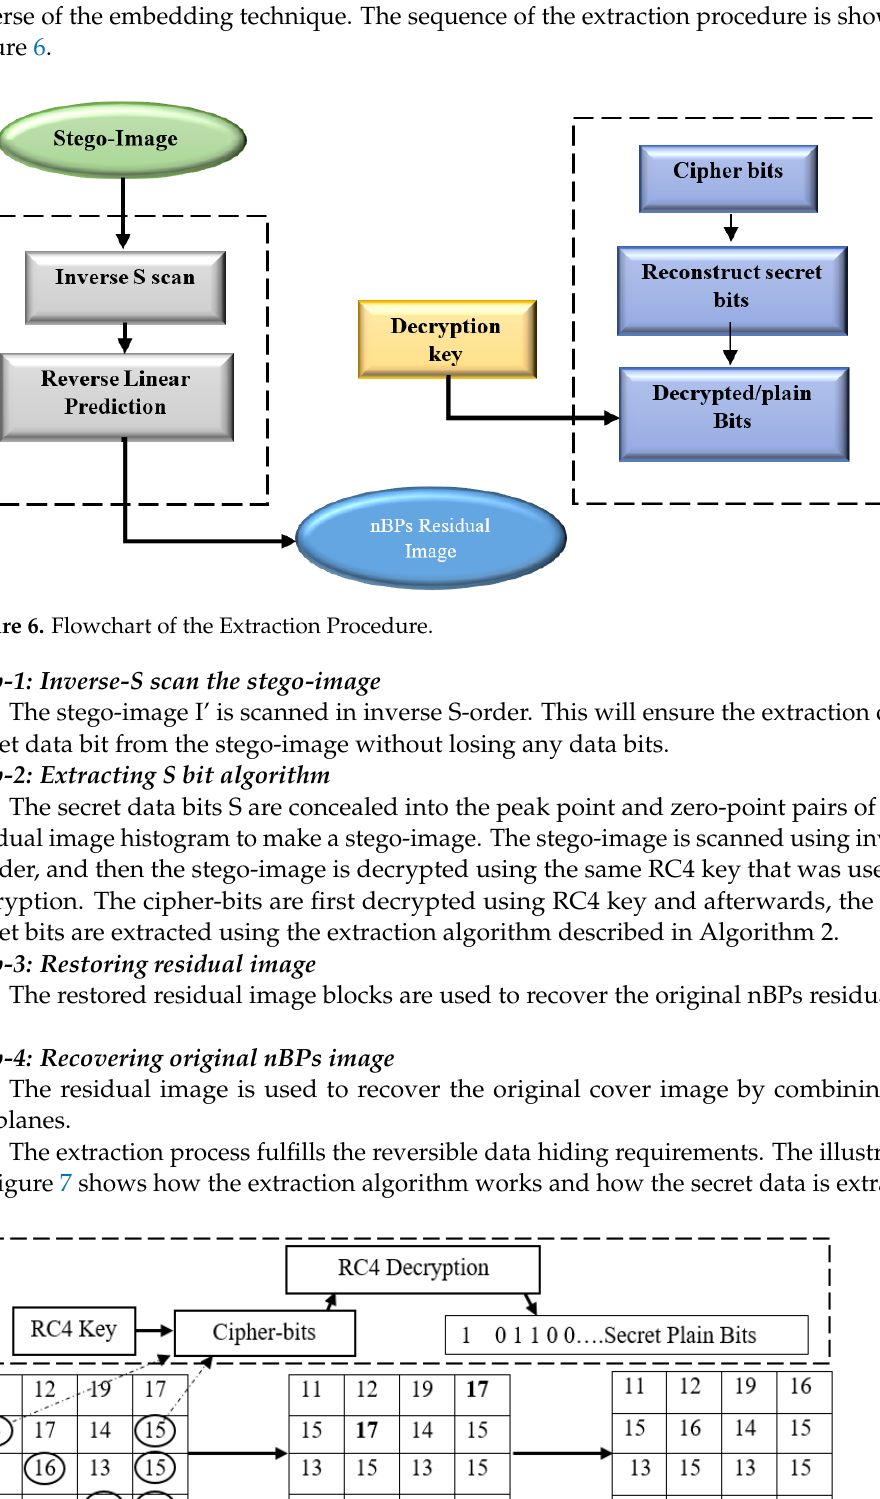
Figure 5. Histogram shifting illustration .